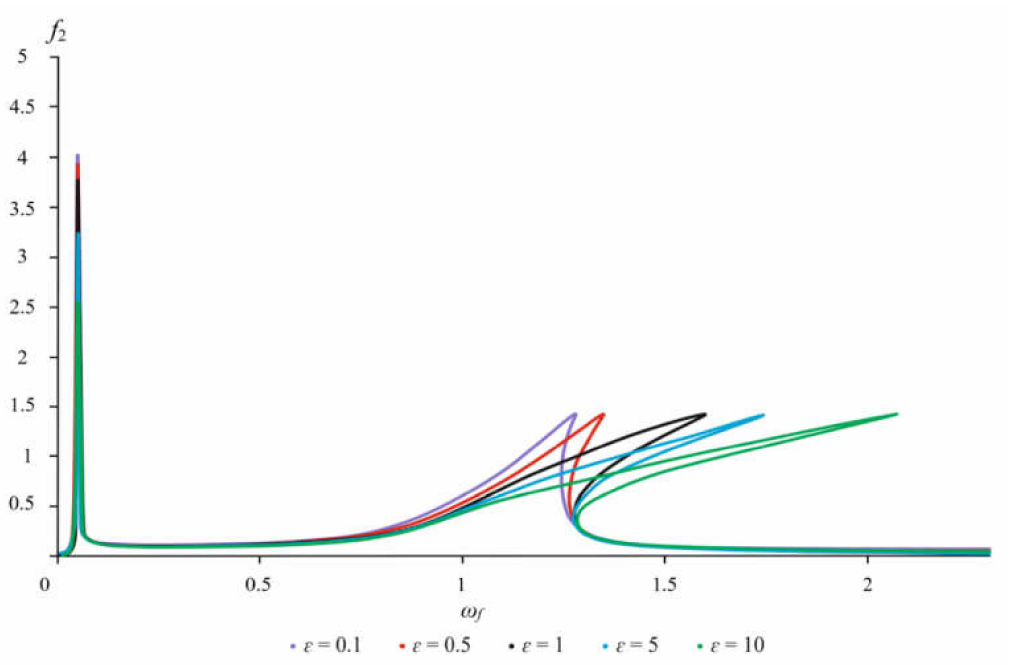
Figure 6. The amplitude-frequency characteristic of the foundation at various degrees of